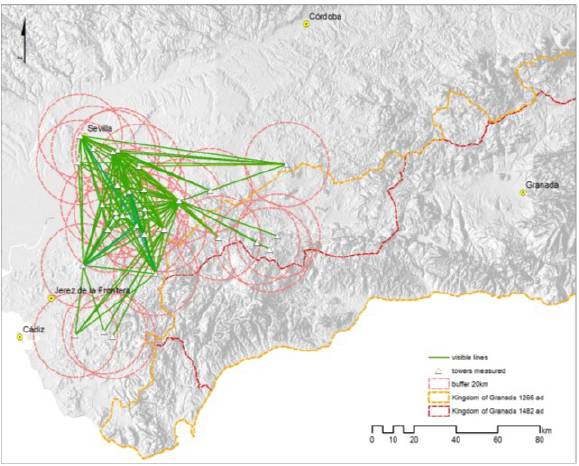
Figure 7. Analysis of visibility. The map shows the network of visual lines between towers.